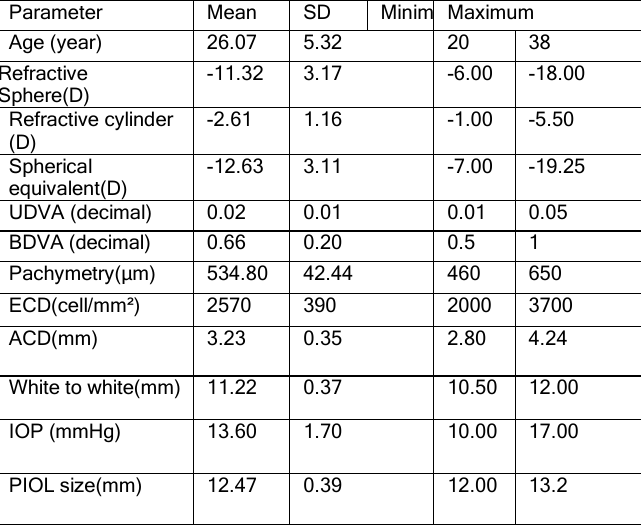
Figure1 :Predictability chart